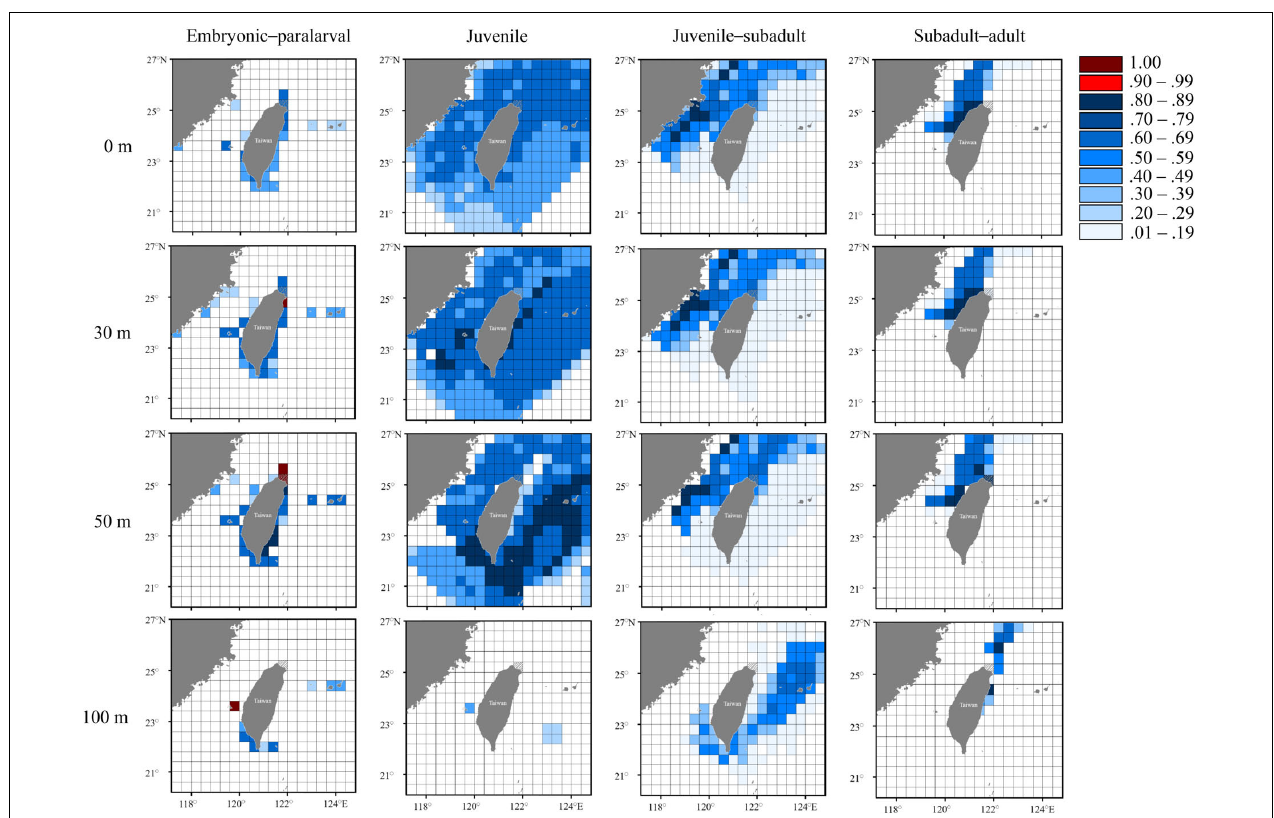
FIGURE 8 | Probability distribution based on experienced temperatures in S. lessoniana individuals in the summer group at each life stage. The legend indicates the probability value of